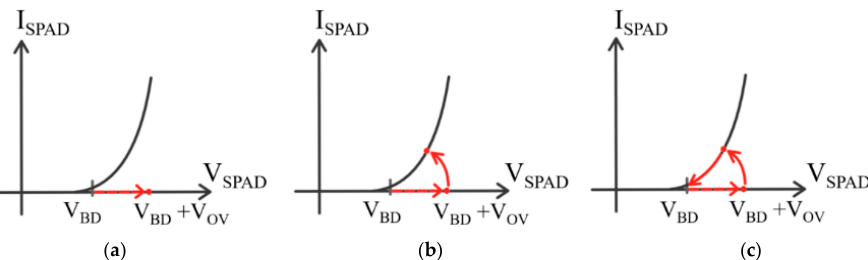
Figure 1. Operation of the SPAD, variation in overvoltage demonstrated in red. ( a ) Device in metastable state, waiting for a photon to hit the surface. ( b ) A photon was detected and a large current flows through the device. ( c ) Quenching is realised, and the bias voltage is brought back to the breakdown voltage. Once the SPAD is recharged, the bias is increased to V BD + V OV and another photon can be